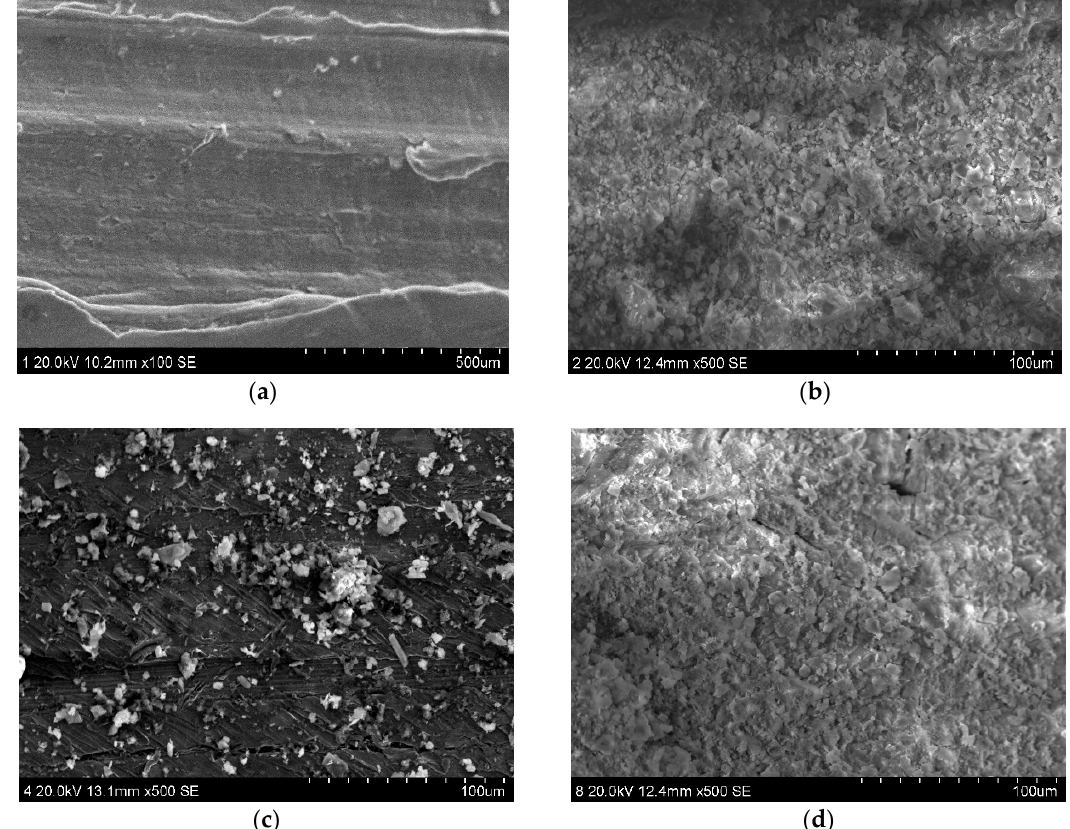
Figure 9. Micrograph of steel fiber pulled out from the concrete: ( a ) before corrosion, plain steel fiber; ( b ) before corrosion, zinc phosphate modified steel fiber; ( c ) after corrosion, plain steel fiber; ( d ) after corrosion, zinc phosphate modified steel fiber.